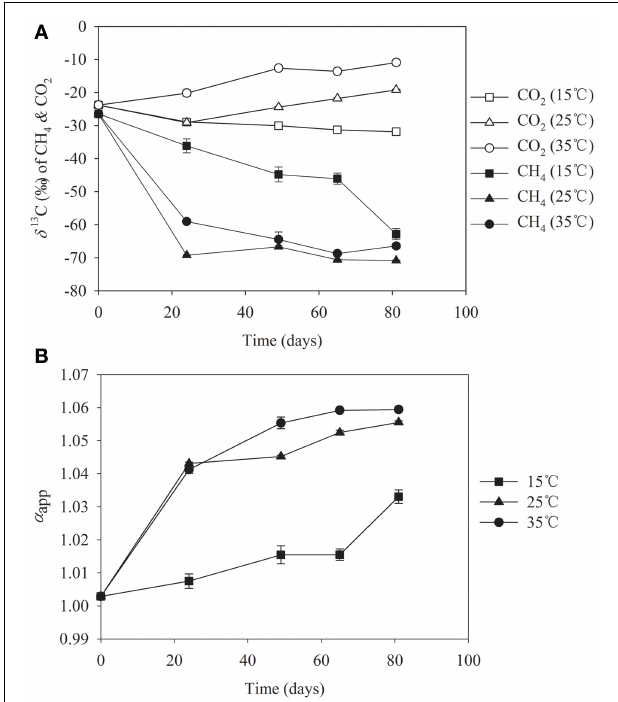
FIGURE 4 | δ 13 C values of CO 2 and CH 4 (A) and the apparent fractionation factor ( α app ) (B) in slurries of Zoige wetland incubated at 15 ◦ C ( (cid:2) ), 25 ◦ C ( (cid:3) ), and 35 ◦ C ( • ),